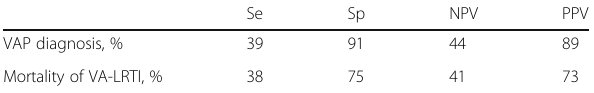
Table 1 (abstract 001652). Accuracy of SEPSIS-3 in diagnosing and predicting mortality of